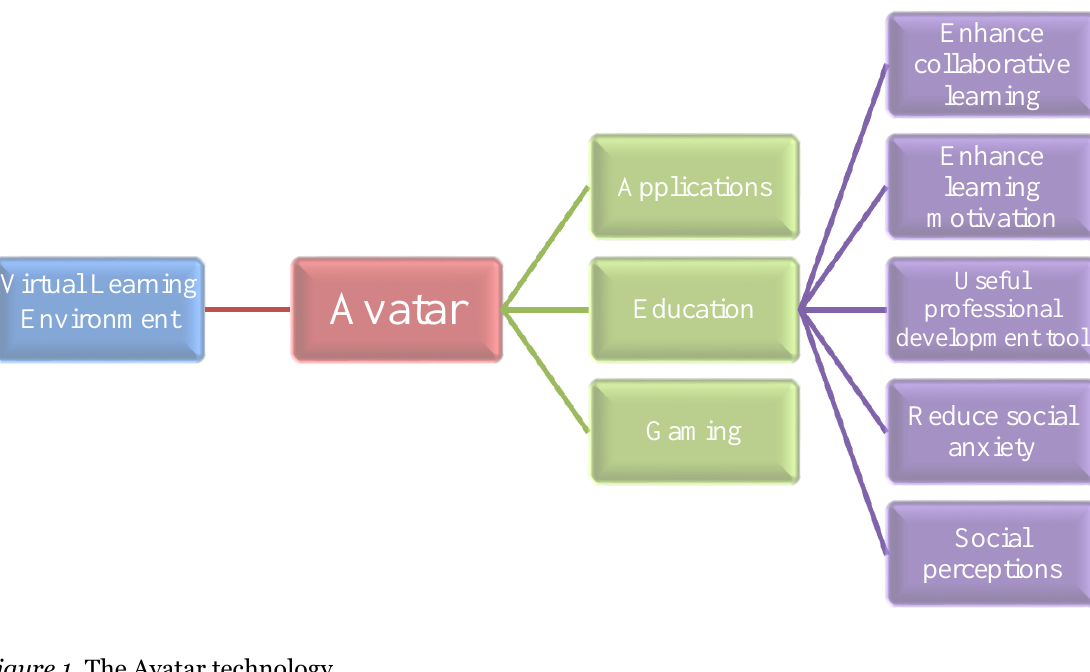
Figure 1. The Avatar